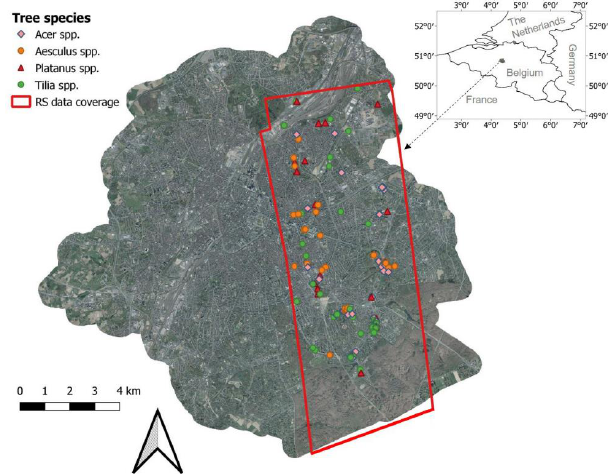
Figure 1. Remote sensing data coverage and locations of sampled trees.